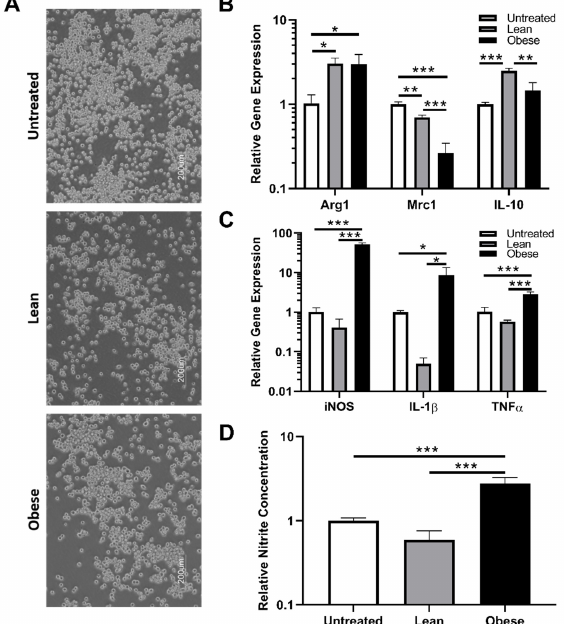
Figure 4. SIM-A9 cells following indirect co-culture with ASCs in a Transwell system. ( A ) Representative images of SIM-A9 morphology following either LnASC or ObASC co-culture. ( B ) Changes in anti-inflammatory gene expression of SIM-A9 cells following 48-h co-culture relative to untreated controls. ( C ) Changes in pro-inflammatory gene expression of SIM-A9 cells following 48-h co-culture relative to untreated controls. ( D ) Griess assay determination of nitrite concentration of 48-h conditioned media following 48-h co-culture relative to untreated cells. Values are presented as means (N = 3) ± SD of three independent experiments using one-way ANOVA followed by Dunnett’s multiple comparison test. Statistical differences between the means are marked with * p < 0.05, ** p < 0.01, *** p < 0.001. Abbreviations: Arg1, arginase 1; Mrc1, mannose receptor C-type 1; IL-10, interleukin 10; iNOS, inducible nitric oxide synthase; IL-1 β , interleukin 1 beta; TNF α , tumor necrosis factor alpha.